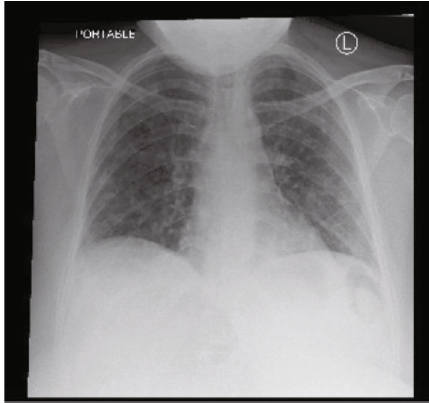
Figure 1: Chest X-ray on arrival showing di ff use bilateral opacities.